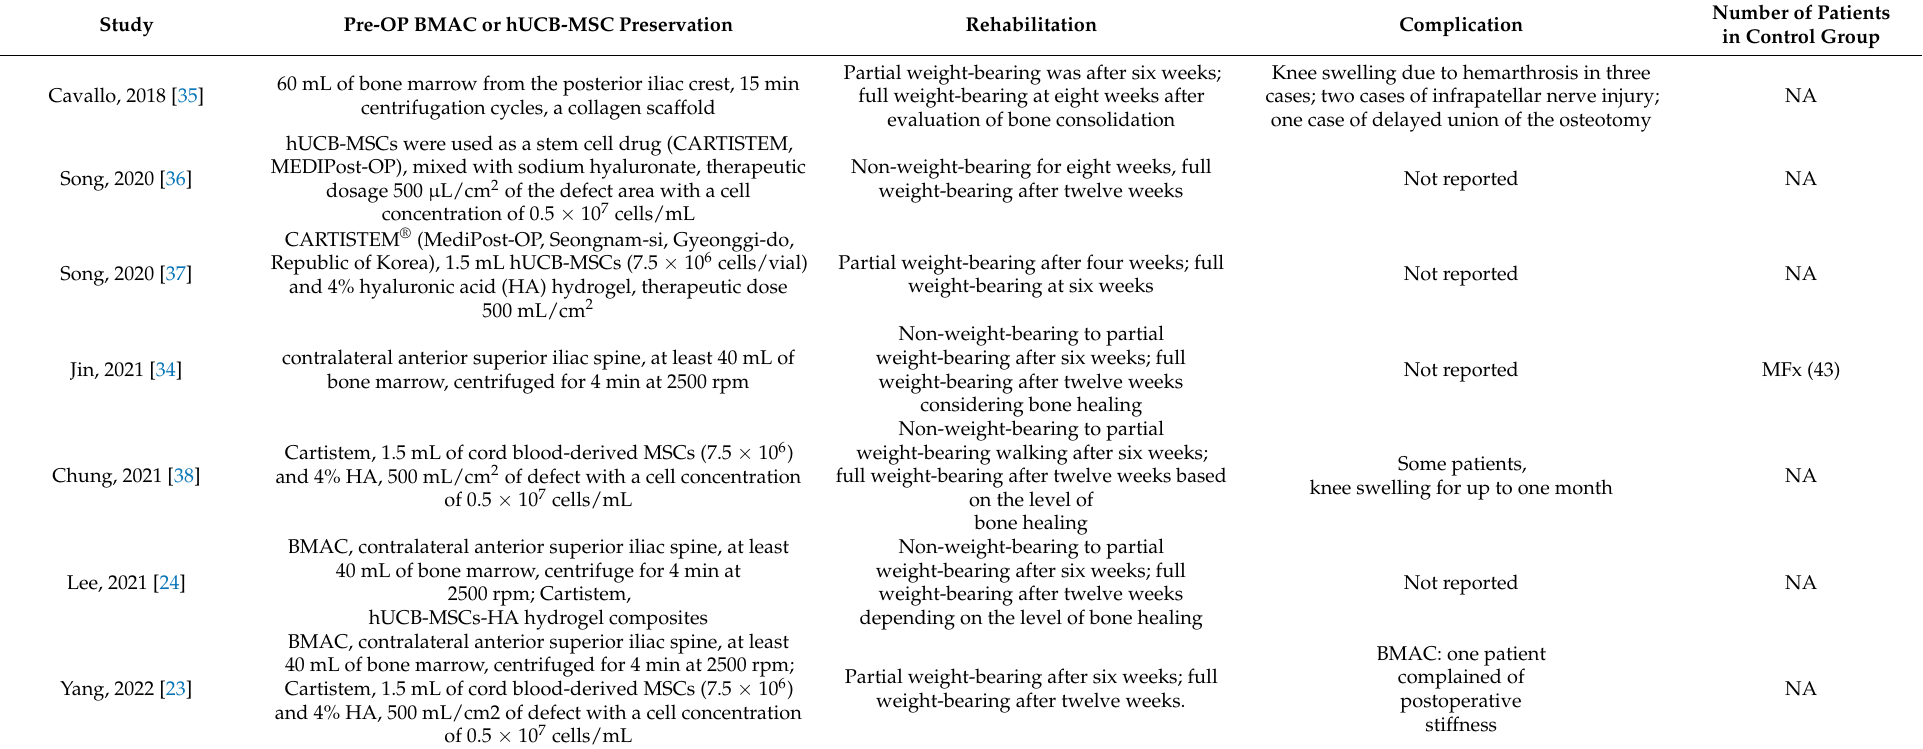
Table 3. Preoperative preservation, rehabilitation and complications of the included